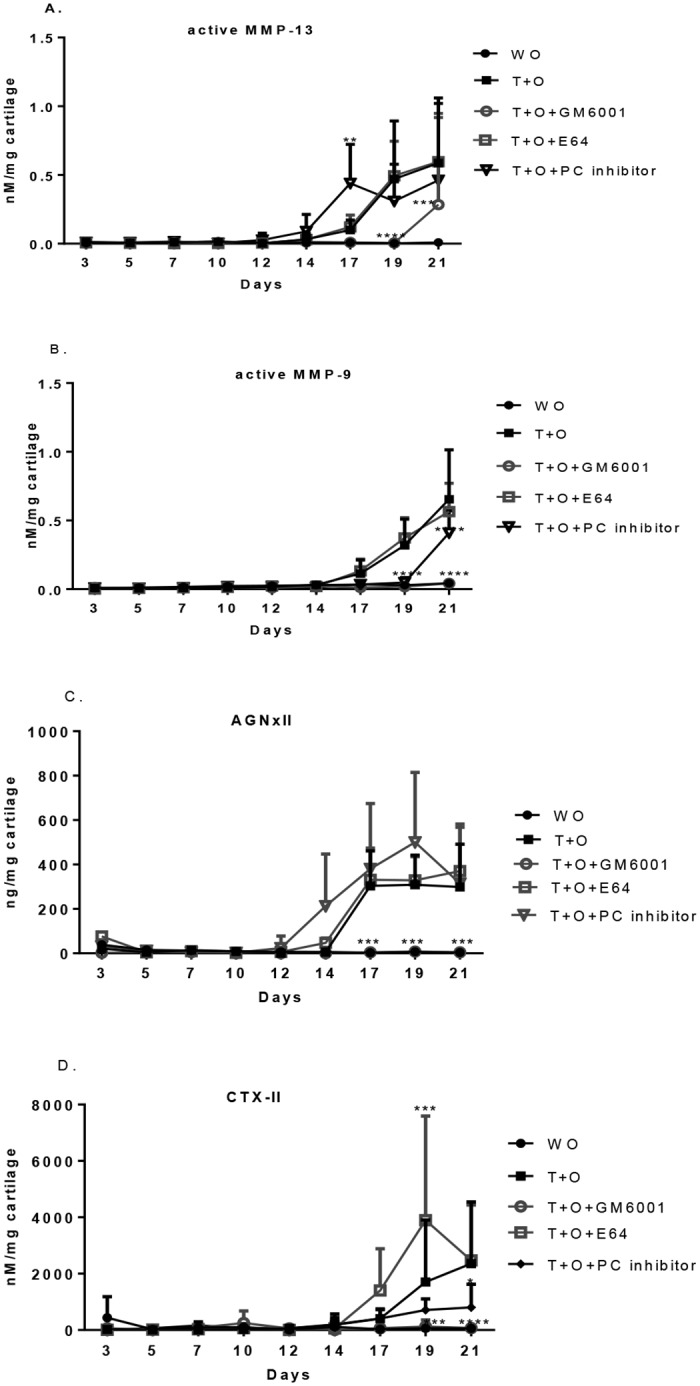
The effect of broad-spectrum inhibitors on the profiling of active MMPs and their specific aggrecan and collagen degradation fragments.(A) active MMP-13. (B) active MMP-9. (C) AGNxI. (D) CTX-II. All values were shown as mean±95% confidence intervals (n = 8 in each group). Error bars indicated the upper limit of 95% confidence intervals.